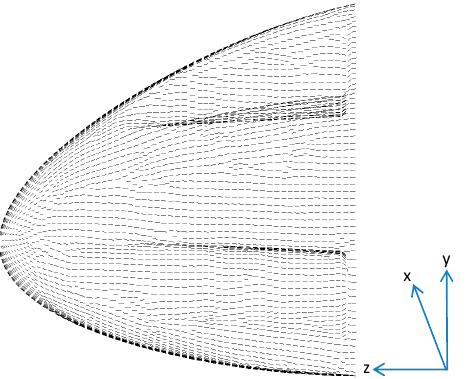
Figure 3. Orientation of composite material (line direction represents reference orientation).